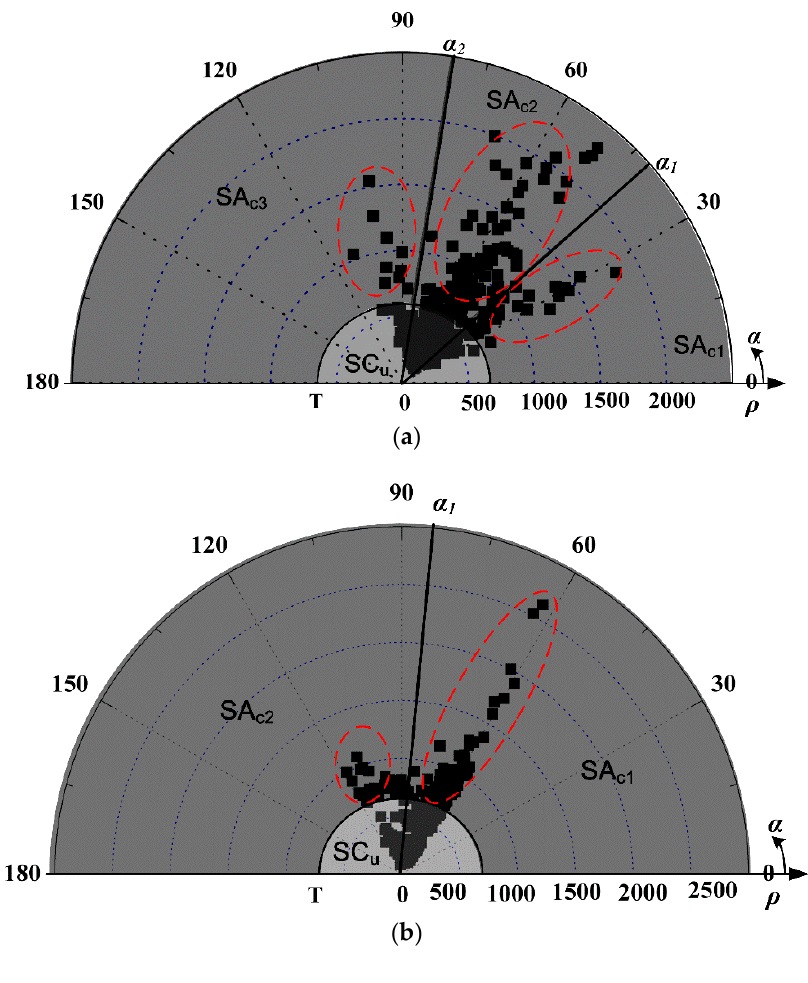
Figure 4. The scattergram in the polar representation for ( a ) proposed SAW-CVA and ( b ) standard CVA.